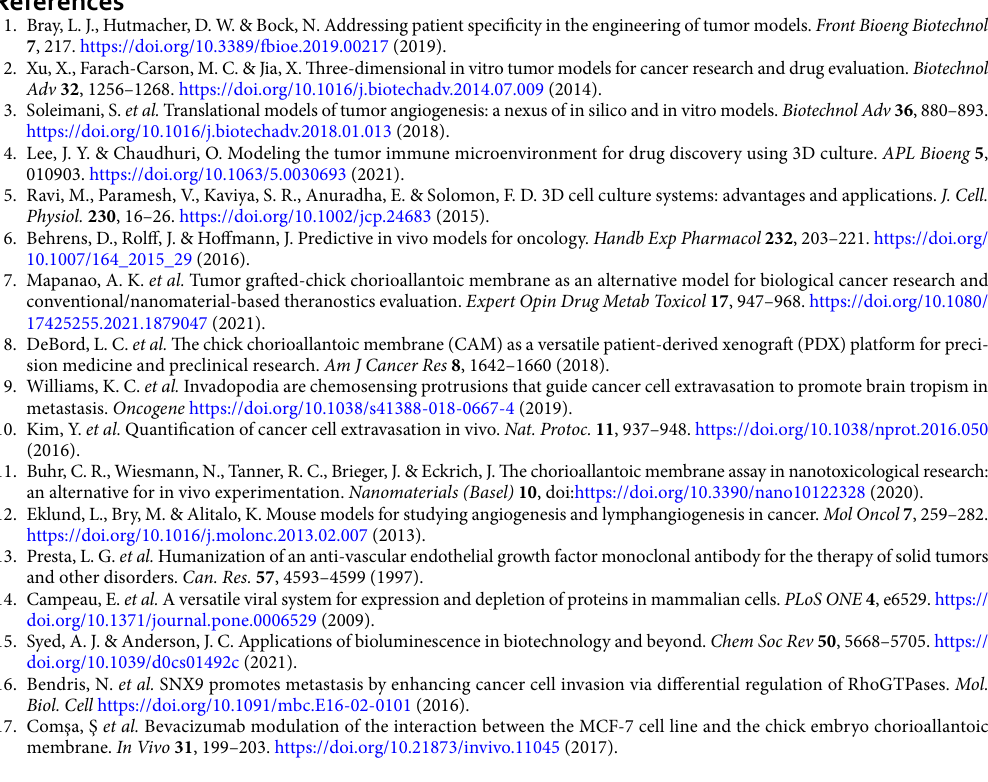
Figure 6. Bevacizumab treatment in MDA-MB-231luc and MCF7luc spheres. (A and B) Bevacizumab treatment of ( A ) MDA-MB-231luc and ( B ) MCF7luc tumor spheres in vitro (n = 5 per group). ( C , D ) Bevacizumab treatment of ( C ) MDA-MB-231luc and ( D ) MCF7luc tumor spheres in vivo, xenografted onto the chick embryo CAM (n = 5–7 per group). Error bars in both graphs represents SEM, asterisk denotes significance, Two-way Anova Multiple Comparison Test. Black arrows indicate the days of the treatment (Day 4 and Day 7). ( E , G ) Representative image of treated, or untreated, tumors on Day 4 and Day 9 for ( E ) MDA-MB-231luc cells and ( G ) MCF7luc cells when observed via a light microscope. ( F , H ) Comparison of control (left) and treatment (right) tumor size when resected at endpoint (Day 9) for ( F ) MDA-MB-231luc cells and ( H ) MCF7luc. ( I ) Total angiogenic area in the tumor periphery of MDA-MB-231 and MCF7 tumors spheres xenograft onto the chick embryo CAM at endpoint (Day 9) treated with axitinib or DMSO control (n = 7 per group). Error bars represents SEM, p -value denotes significance, Tukey’s